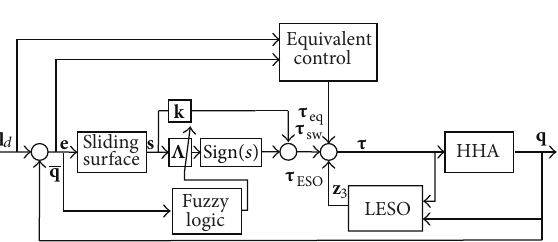
Figure 4: The block diagram of the